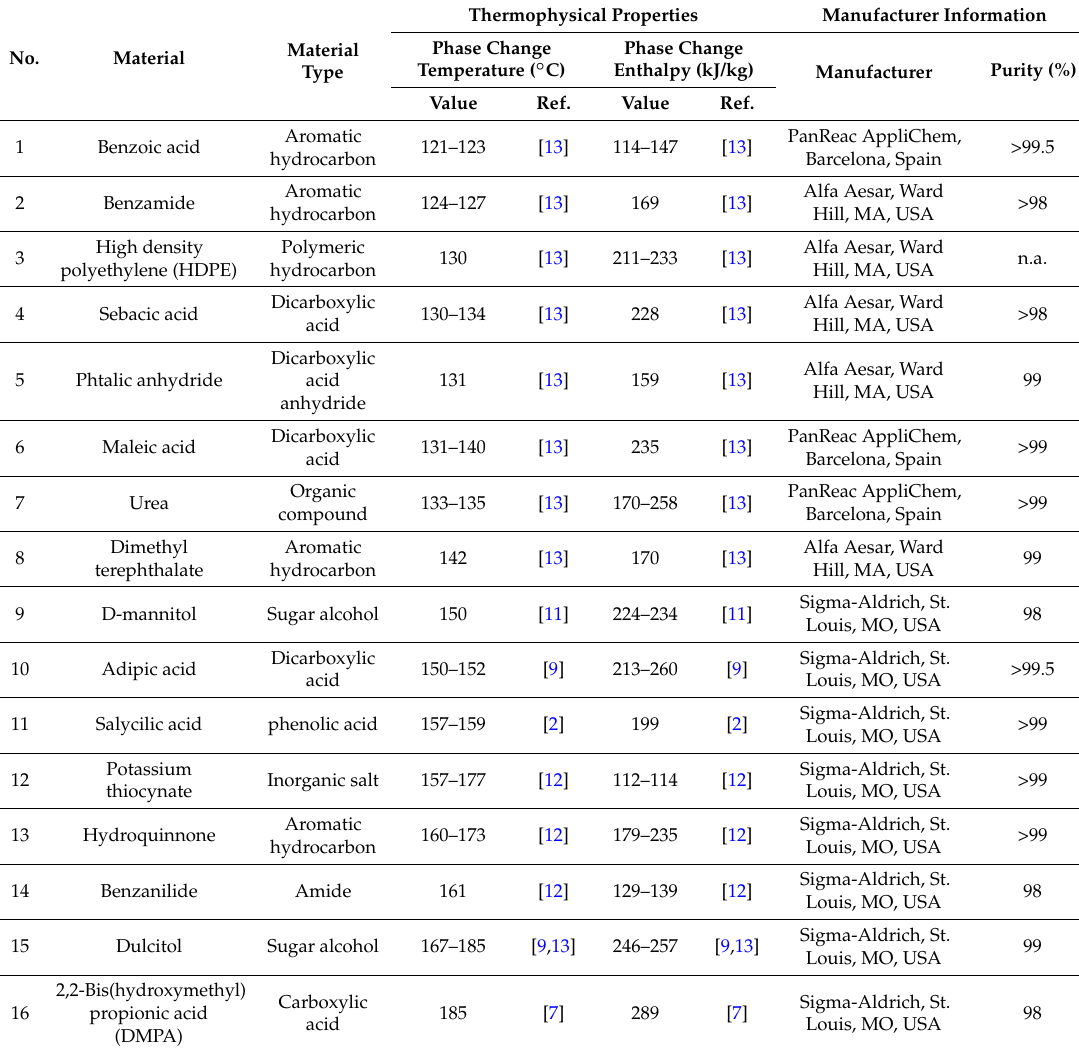
Table 2. PCM candidates for thermal energy storage processes working under partial load operating conditions within a temperature range between 120 and 200 ◦